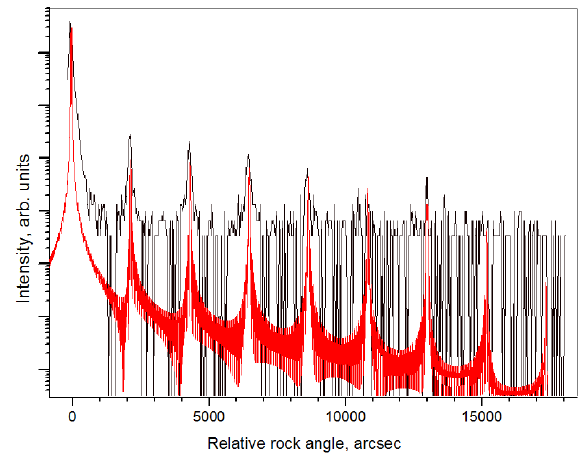
Figure 7. X-ray curve and modeling of the superlattice AlGaAs / GaAs structure.